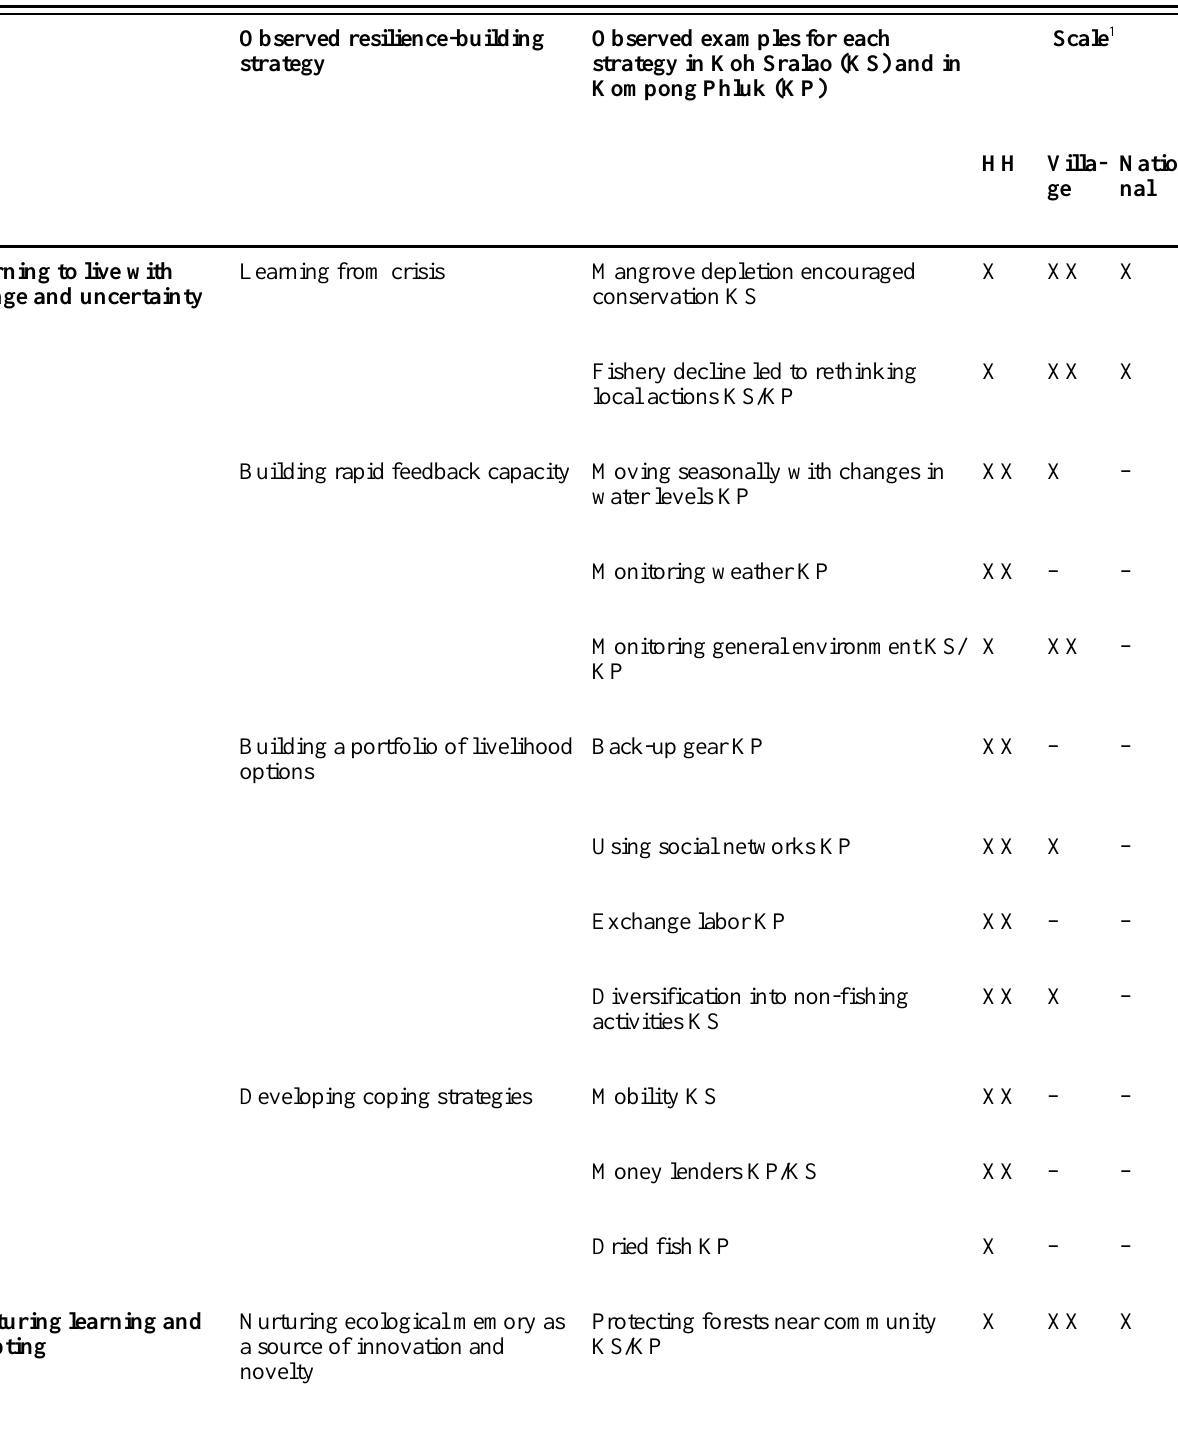
Table 2. Observed resilience-building strategies in Koh Sralao and in Kompong